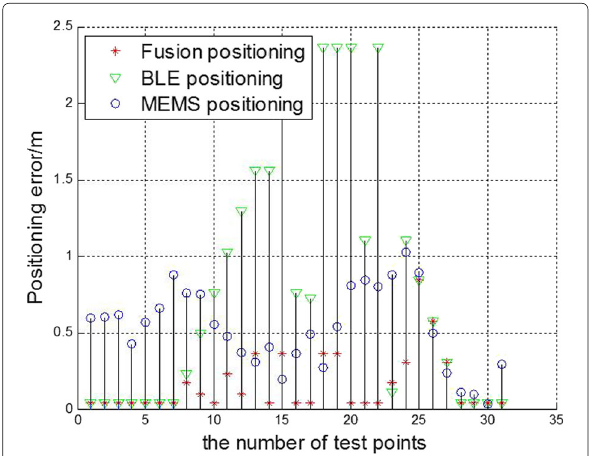
Fig. 30 Height error at each test